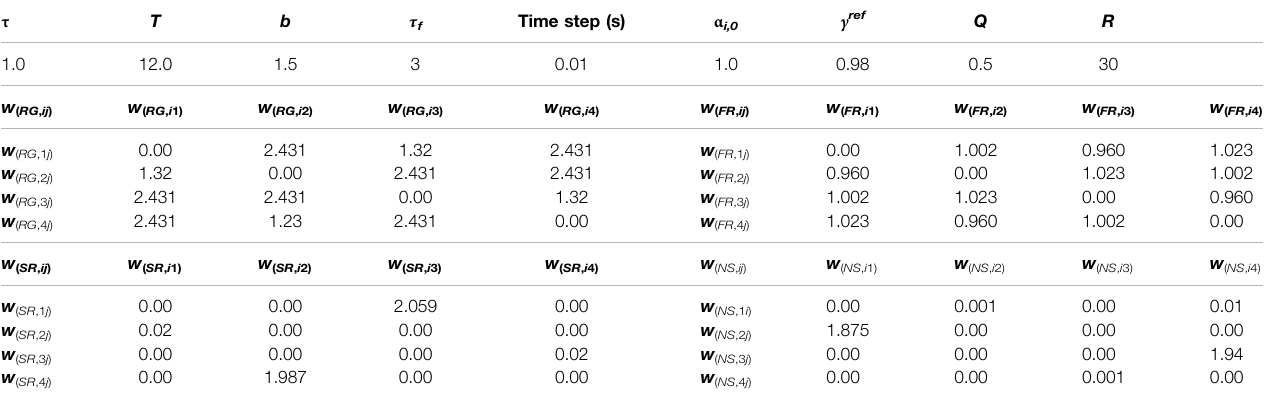
TABLE 6 | Optimized parameter of